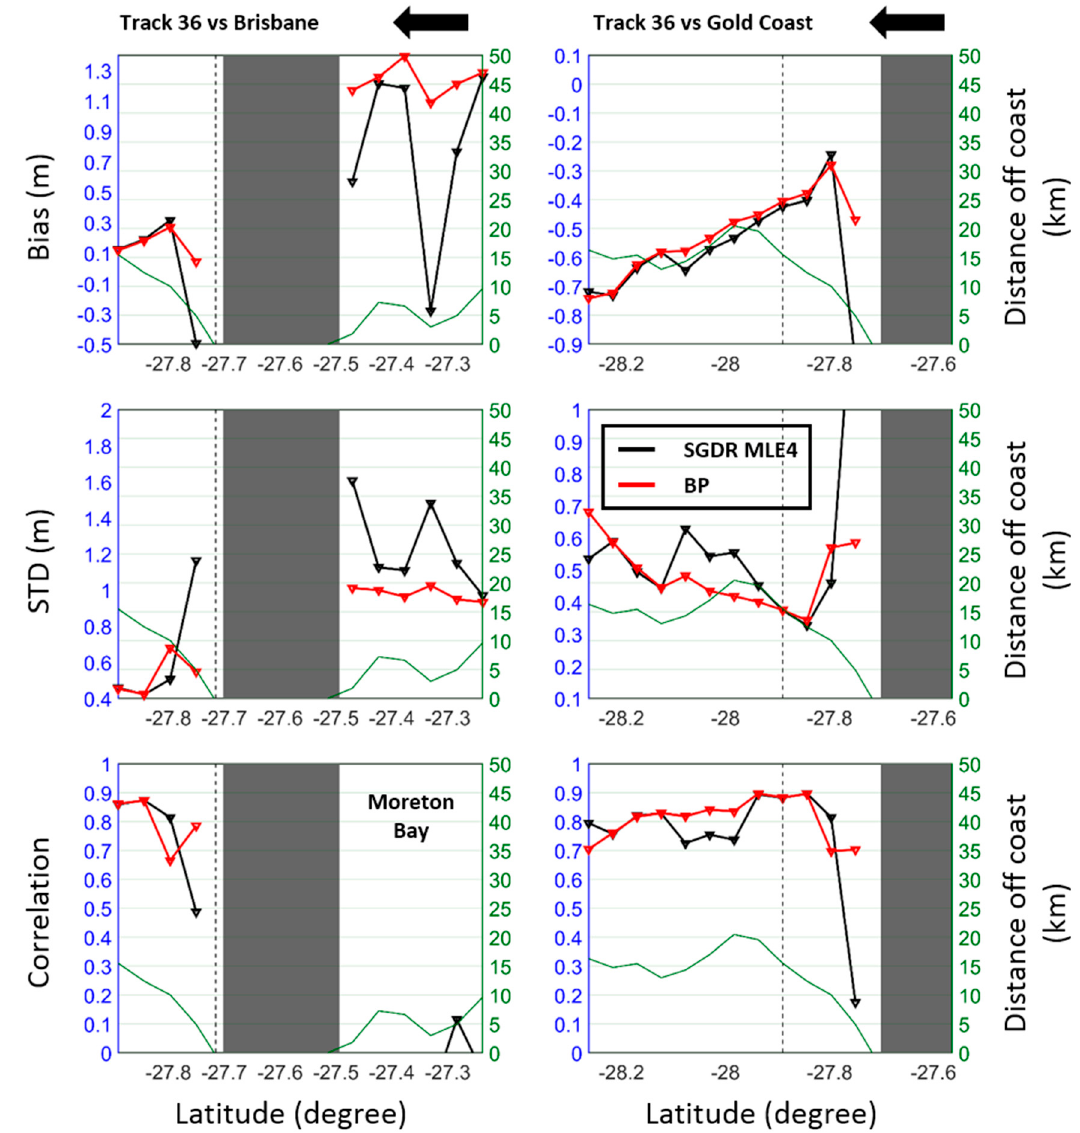
Figure 7. Similar to Figure 5, but for tracks 36 against buoy SWHs at Brisbane ( left ) and Gold Coast ( right ) in South Queensland. The correlation (bottom in left panel) is not computed and shown, as the number of SWHs at the point is less than 30.